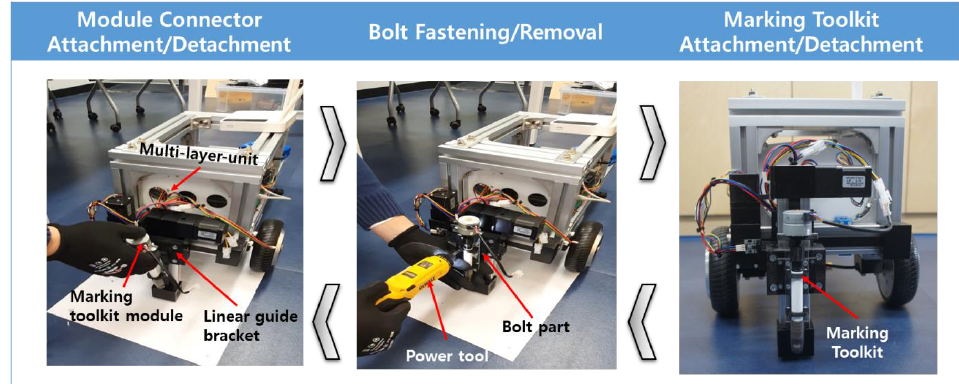
Figure 6. Marking toolkit attachment and detachment test process.